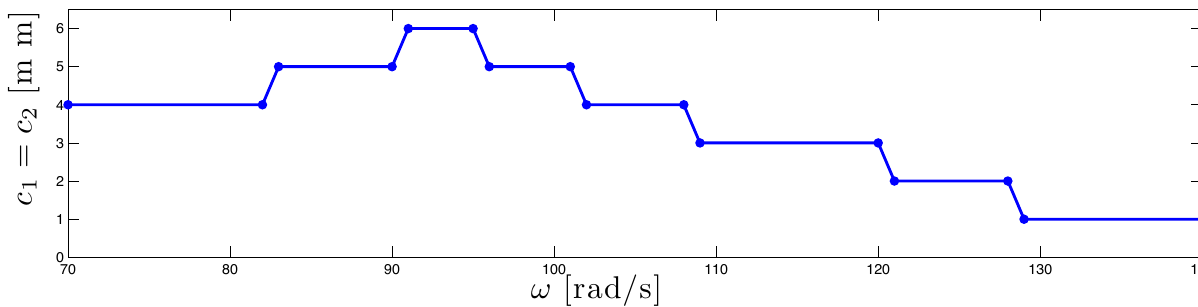
Fig. 12 Optimal choice of the clearance c 1 = c 2 for the maximal attenuation of vibrations of the rotor body corresponding to the red curve in Fig. 9, for parameters m t = 25 kg and b t = 500 N s m − 1 .